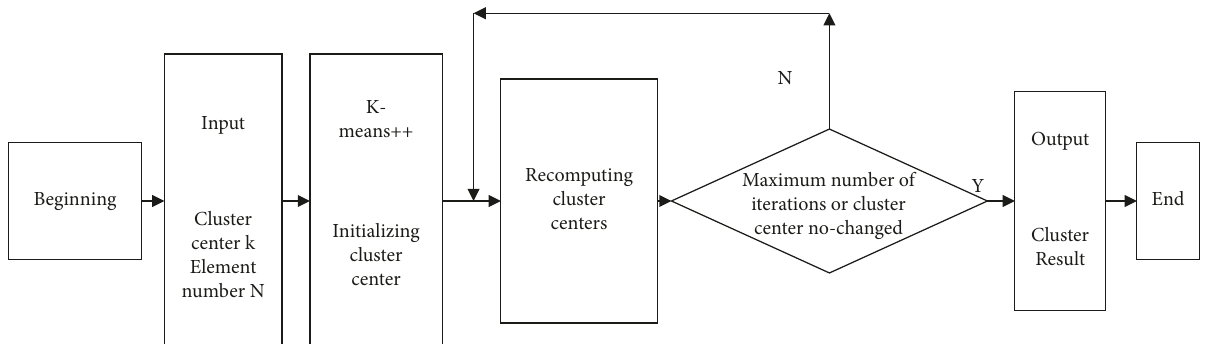
Figure 13: K-means clustering process of our detection